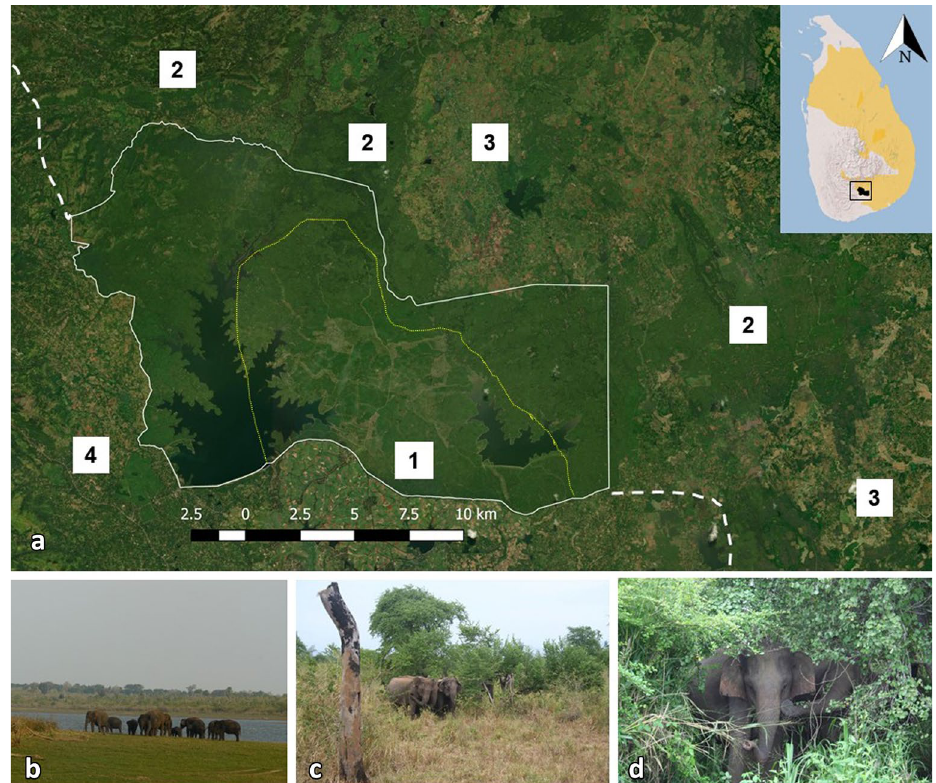
Figure 1. Study site. ( a ) Udawalawe National Park is located in southern Sri Lanka along one of the edges of elephant range in the country (shaded yellow, inset and white dashed line) and contains two reservoirs constructed between 1970 and 2000 as well as smaller water sources. Solid outlines show recognized park boundaries, dashed outlines show edge of elephant range. Area 1 (yellow dotted line) is the observation area with an accessible road network (visible); areas of type 2 represent forested sanctuaries or mixed-use lands of varying designations for which boundaries are not always clear; areas of type 3 represent agriculture and settlement mosaics in which elephants are present; areas of type 4 represent agricultural mosaics with denser settlements where elephants are absent except for occasional incursions by bulls. Areas 2–4 are shown for context, but observations were only performed in area 1. Basemap source: ESRI ® World Satellite Map. ( b – d ) Examples of habitat found in the study area, ranging from open floodplain to dense